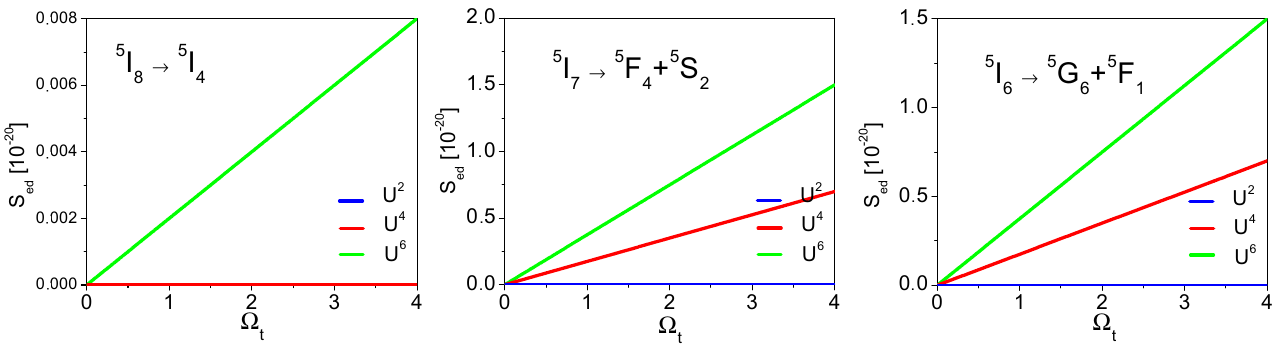
Ω Figure 10. S ed values’ dependence on Ω t parameters for transitions involved in 750 nm up-conversion excitation. Figure 10. S t parameters for transitions involved in 750 nm up-conversion ed values’ dependence on